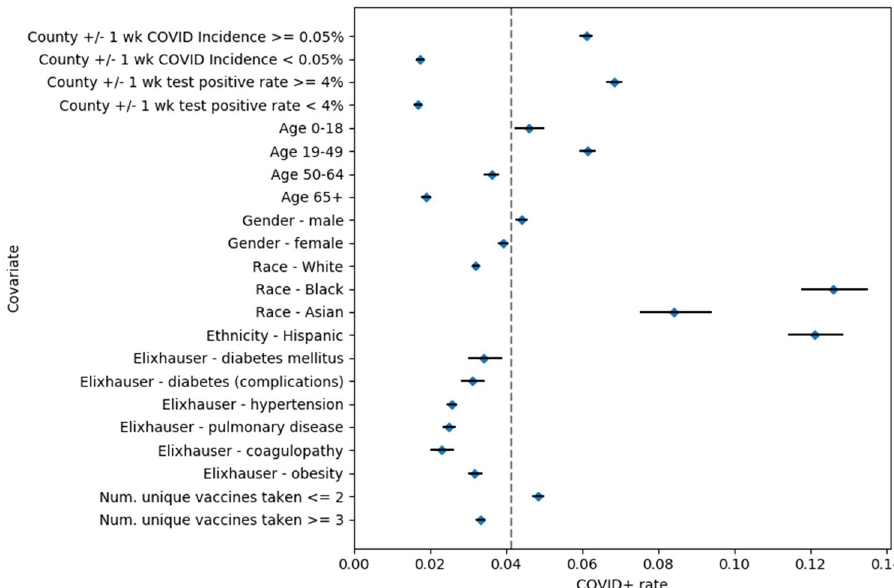
Figure 2. SARS-CoV-2 infection risk ratios by clinical covariate. SARS-CoV-2 rates among individuals with particular clinical covariates along with 95% confidence intervals. A dotted line indicates the study population SARS-CoV-2 rate of 4.4%. The clinical covariates include: county-level COVID-19 incidence and testing rates, age brackets (< 18, 18–49, 50–64, 65+ years), gender, race, ethnicity, Elixhauser comorbidities, and number of unique vaccines